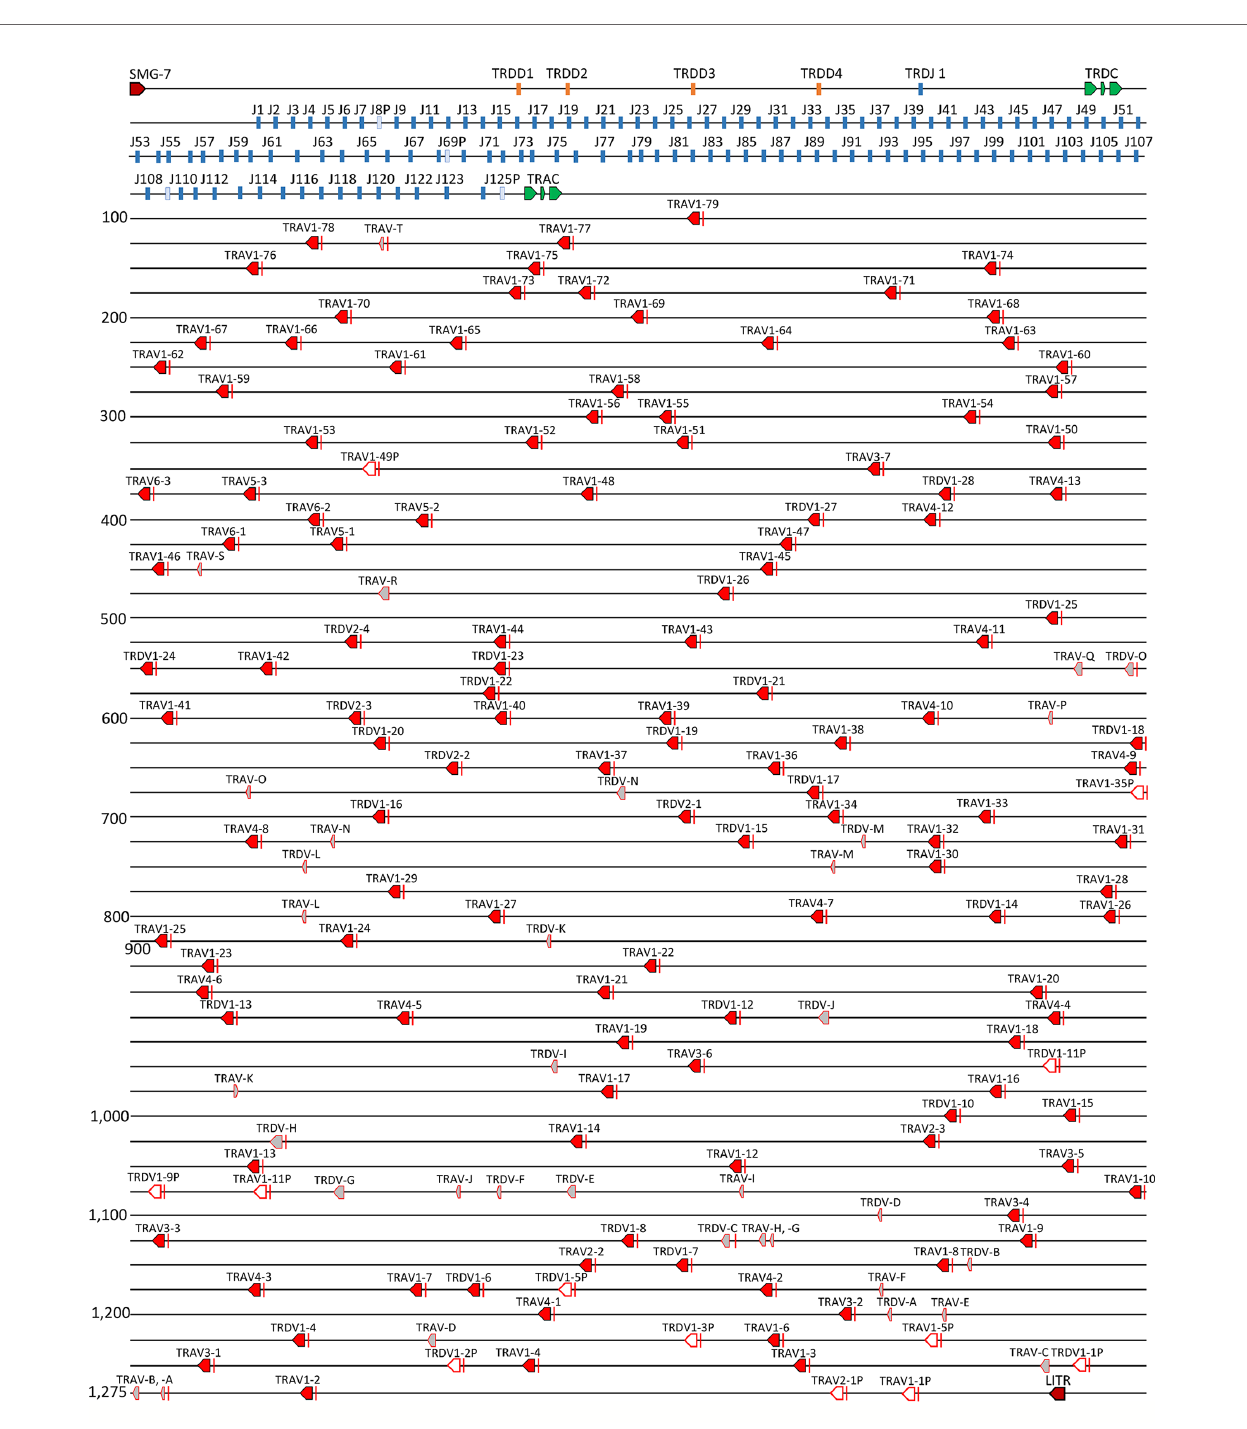
FIGURE 4 | The channel cat fi sh TRAD locus. Schematic representation of the channel cat fi sh TRAD locus. Red arrows mark the location and direction of transcription for each of the TRAV genes and the TRDV genes. Green arrows mark the location of the TRDC and TRAC genes. The TRAJ genes are colored blue and the TRD D genes are in orange. Pseudo J genes are in pale blue, V gene remnants are in grey, and labeled with letters A-T. The two genes that fl ank the locus, nonsense mediated mRNA decay factor (SMG-7) and leukocyte immune type receptor (LITR) are